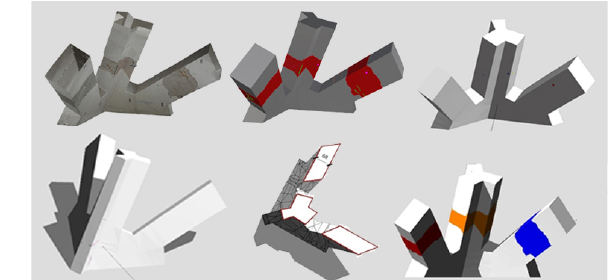
Figure 16 . As-built modelling for NURBS generation and implementation of HBIM 3D model (integration with the structural analyses carried out during the investigation phase).